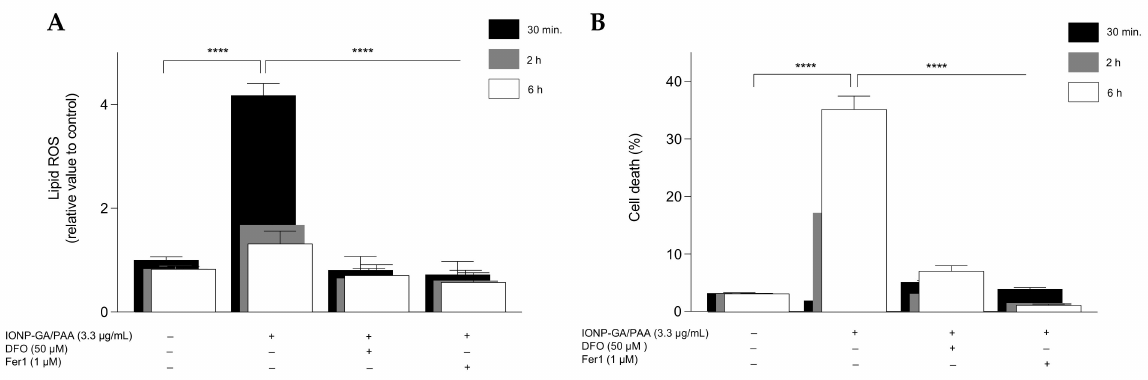
Figure 5. IONP–GA/PAA induced-lipid peroxidation in HT1080 cells is blocked by ferroptosis inhibitors. ( A ) Flow cytometry analysis of the lipid peroxidation sensor (C11-BODIPY-581/591 dye) on live-gated cells (DRAQ7-negative cells) after treatment of HT1080 cells with